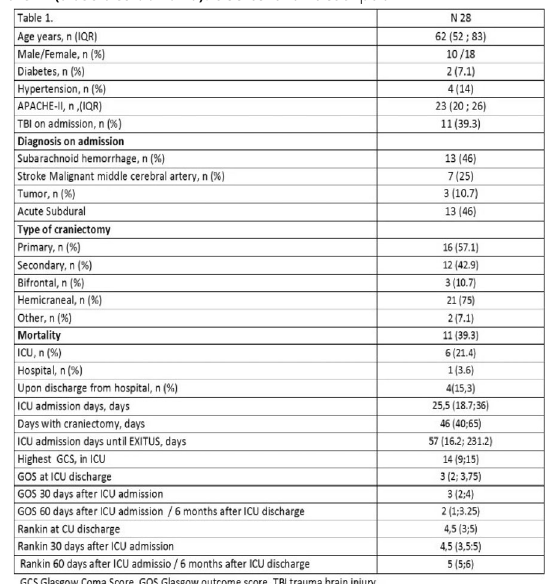
Table 1 (abstract 001016). See text for description